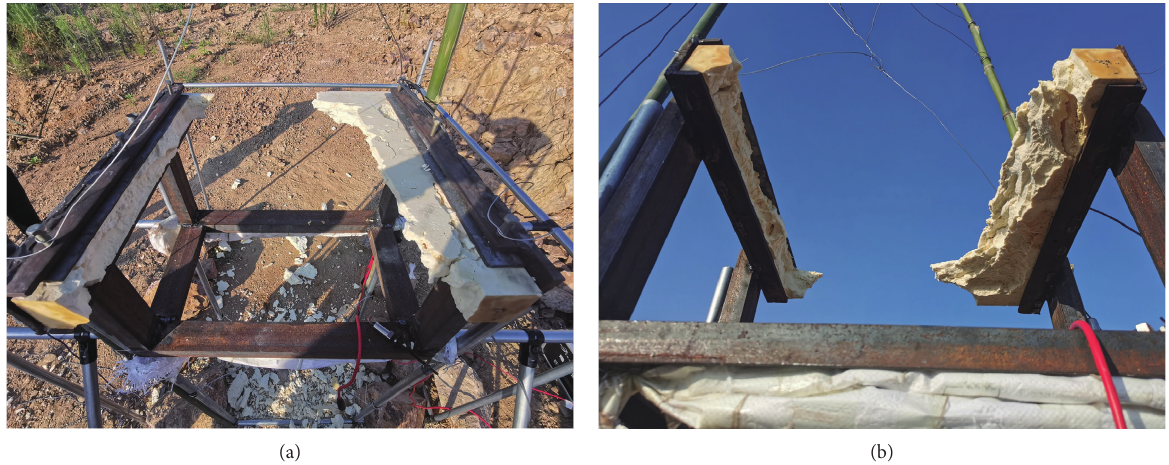
Figure 15: Test results of polymer slab B4 under 50 g explosive. (a) Top surface. (b) Bottom surface.